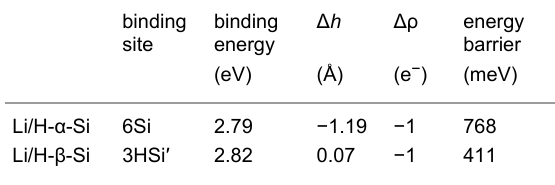
Table 2: The calculated ground-state properties of a Li atom on H- α -Si and H- β -Si: binding site, binding energy, distance from adsorbed Li atom to the surface of H atoms Δ h , the amount of charge donated by the Li atom Δρ , and the energy barrier (relative to the binding